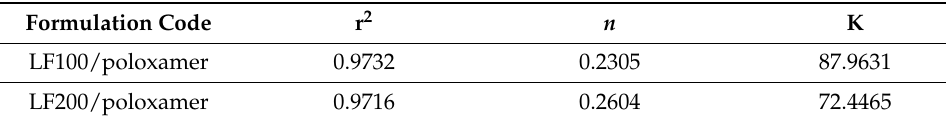
Table 3. Release kinetic parameters of LF from the poloxamer gel